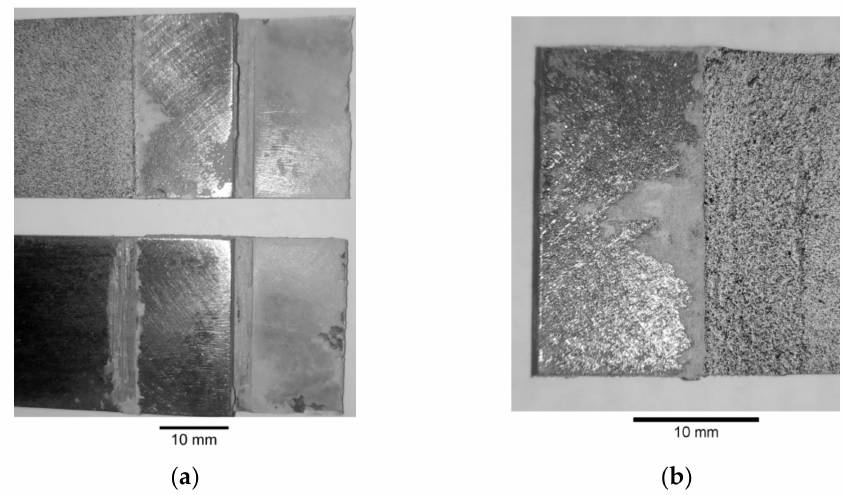
Figure 18. Failure modes of samples with composite overlays with visible steel/adhesive interfacial failure: ( a ) τ avg,FAT = 11.03 MPa; ( b ) τ avg,FAT = 10.36